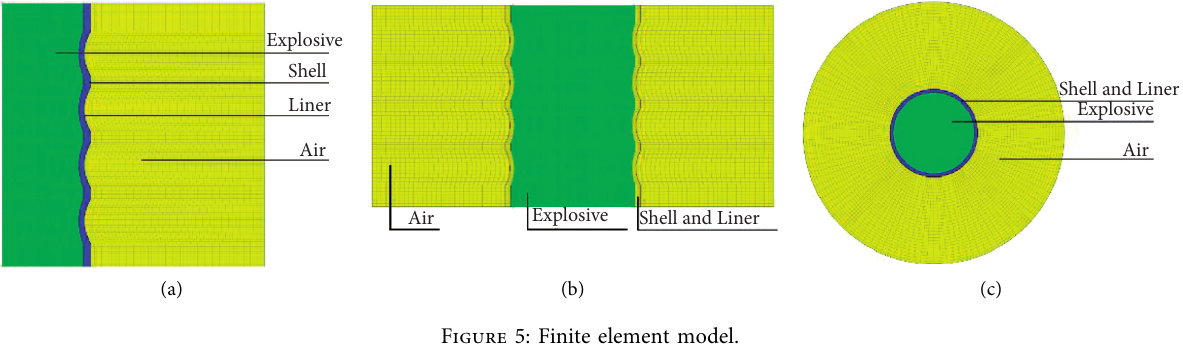
Figure 5: Finite element model.